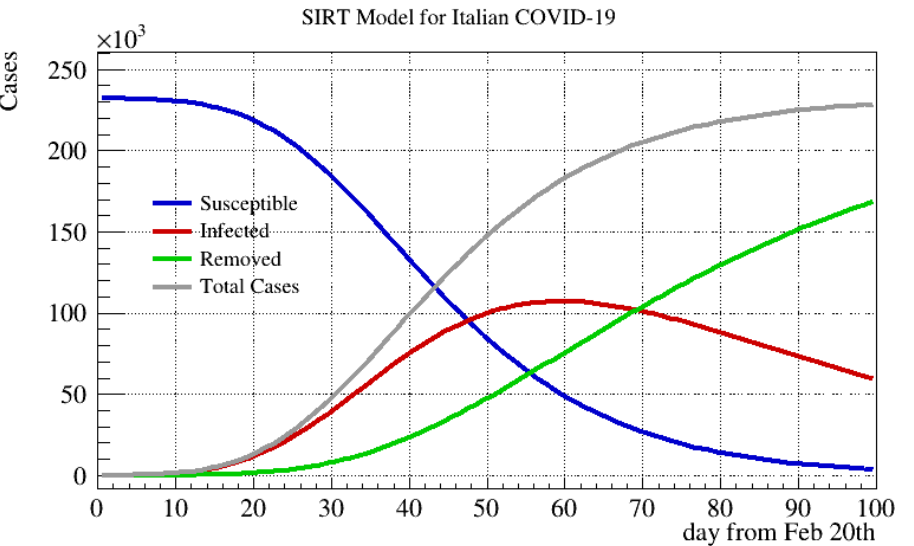
Figure 2. Example of time-dependent susceptible–infectious–recovered (SIR) model prediction, in which the basic reproduction number decreases exponentially from the beginning of the disease epidemic outbreak. The initial susceptible population S (blue) is converted into infected I (red) according to the time-dependent basic reproduction number, R 0 . Finally, according to the strength of the recovery rate, γ , population I is converted into removed R (green). The grey curve represents the sum of R+I, and is usually very well approximated by a logistic curve (the parameters used in these examples are 1/ β ∼ 2.5 days, where β is the transition rate, and 1/ γ ∼ 35